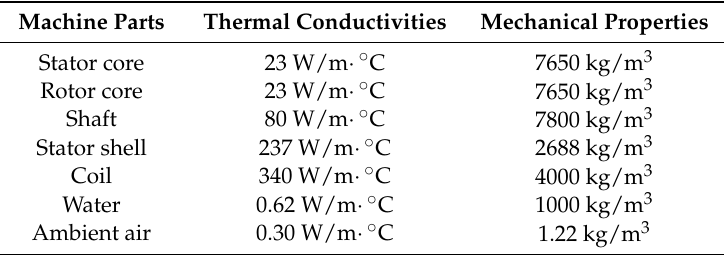
Figure 14. Configuration of the heat equivalent circuits for four HEFS machines. ( a ) PM ‐ top; ( b ) PM ‐ bottom; ( c ) PM ‐ middle ‐ 1& ‐ 2. Table 3. Thermal and mechanical properties of different materials.